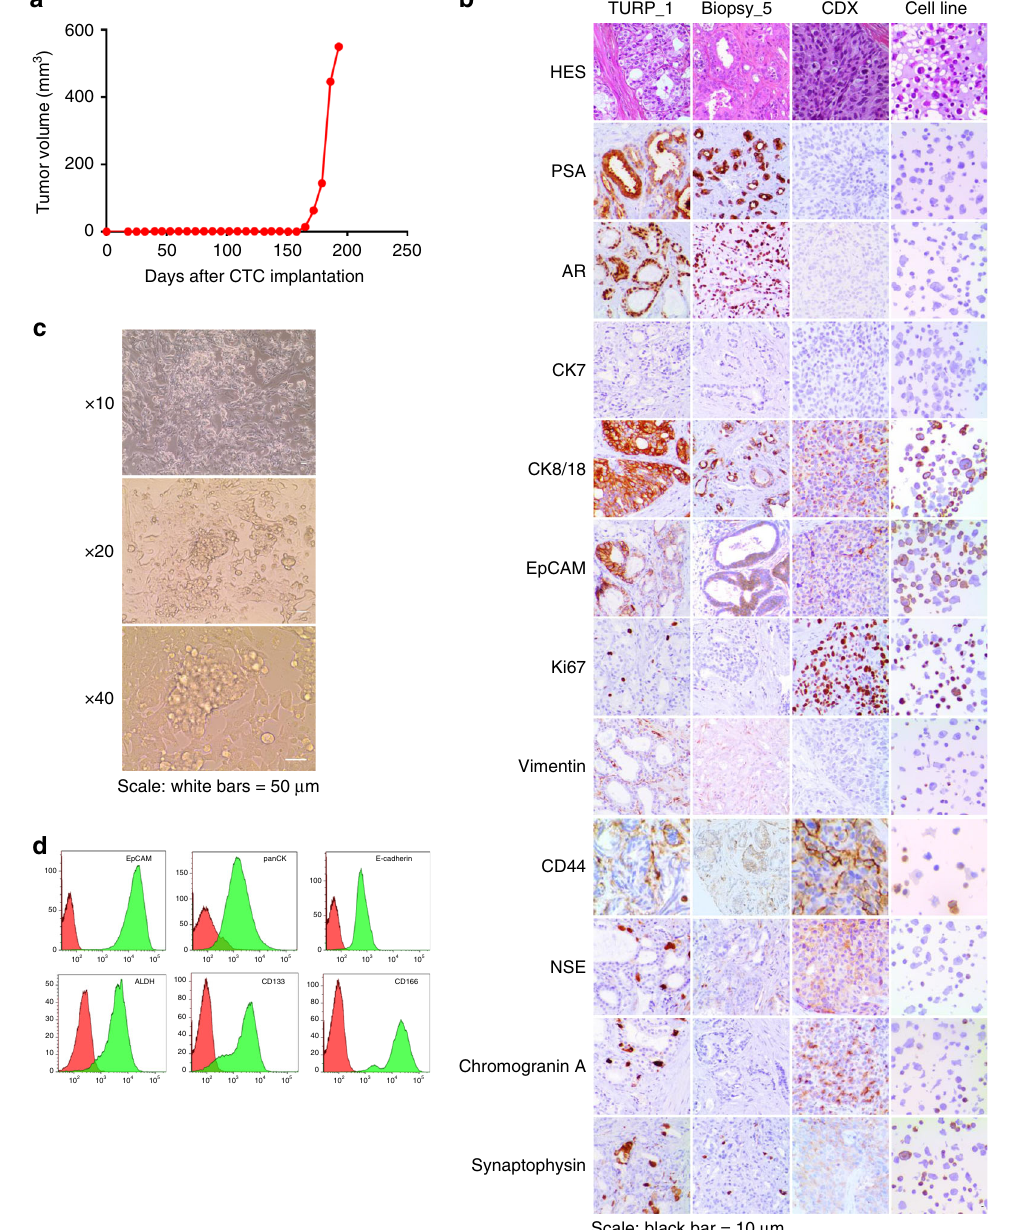
Fig. 1 Establishment and phenotypic characterization of the CDX and the CDX-derived cell line. a Tumor growth curve of the CDX showing the tumor volume (mm 3 ) according to the number of days after CTC implantation. b Immunohistochemical characterization of PT specimens, the CDX, and the CDX- derived cell line. Representative images of HES, PSA, AR, CK7, CK8/18, EpCAM, Ki67, Vimentin, CD44, NSE, Chromogranin A, and Synaptophysin stainings of TURP_1, Biopsy_5, the CDX, and the CDX-derived cell line are shown at ×20 magni fi cation. Scale bar represents 10 µ m. c Representative images of the CDX-derived cell line at ×10, ×20, and ×40 magni fi cation. Cells were growing by forming an adherent monolayer and microspheres. d Phenotypic characterization of the CDX-derived cell line by fl ow cytometry. Expression of epithelial markers, including EpCAM, pan-cytokeratins, and E-cadherin, of CD133 and CD166 cancer stem cell markers and ALDH activity are proportion of CDX mutations including a G279E TP53 mutation. All identi fi ed mutations are described in the Supplementary Data 2.